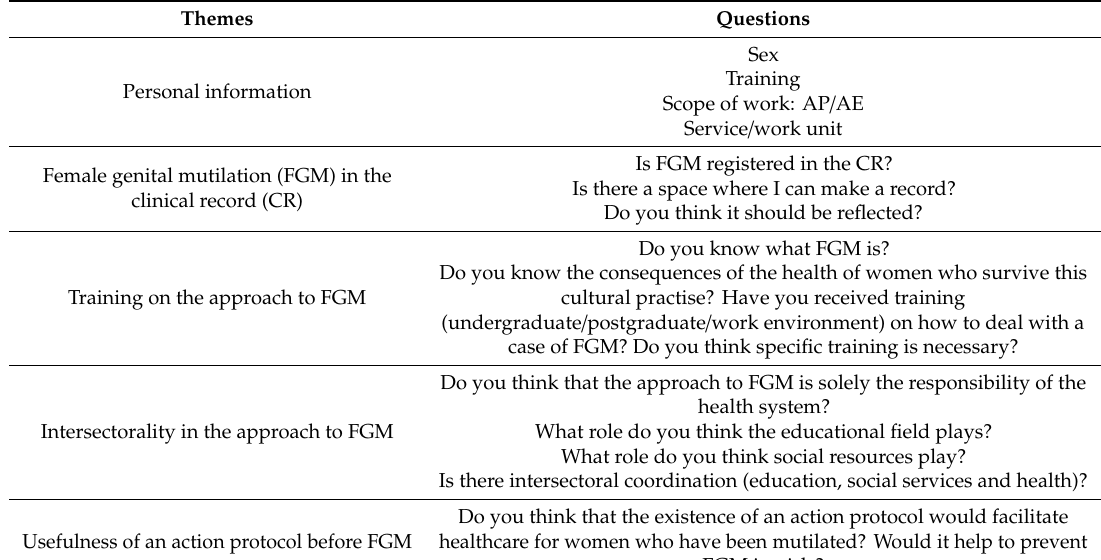
Table 1. Outline of the contents and the script of the interviews and the discussion